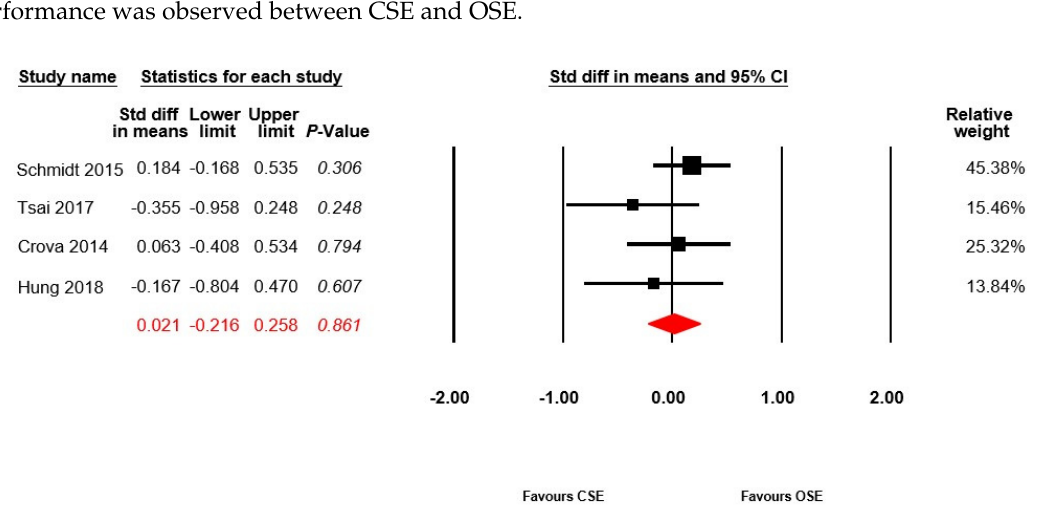
Figure 3. Forest plot for the efficacy of OSE compared to CSE in intervention studies.